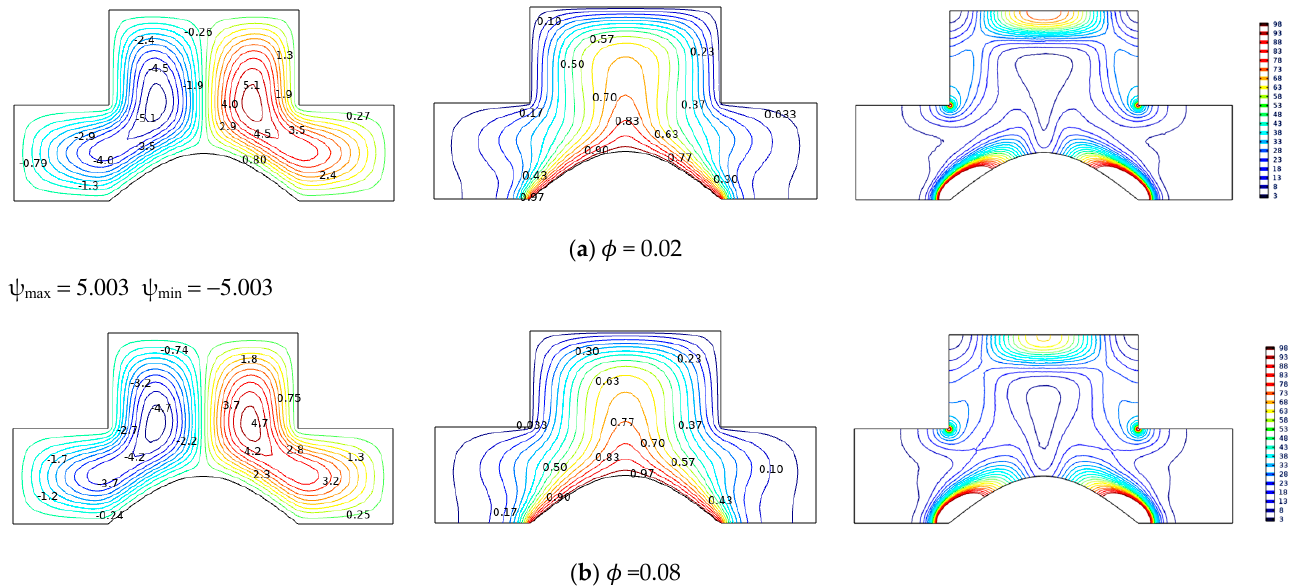
Figure 13. Variations of the streamlines ( left ), isotherms ( middle ), and entropy generation ( right ) with various solid volume fraction ( φ ) at Ra = 10 6 , Ha = 50, ε = 0.4, and Da = 0.01.